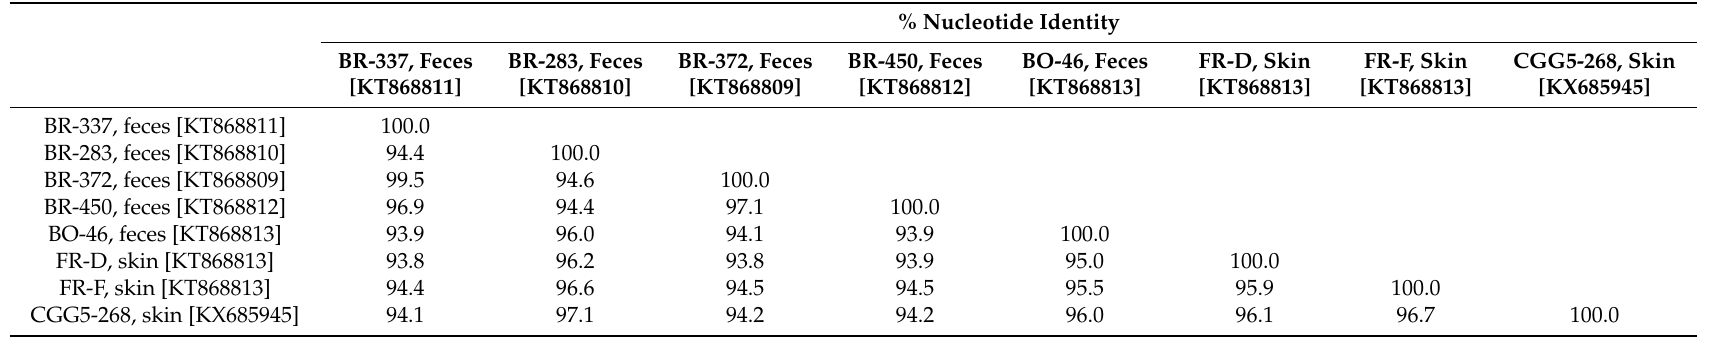
Table 4. Nucleotide identities between the currently available CuV sequences. A sequence of approximately 3980 nts, covering the partial NS1 and complete VP regions